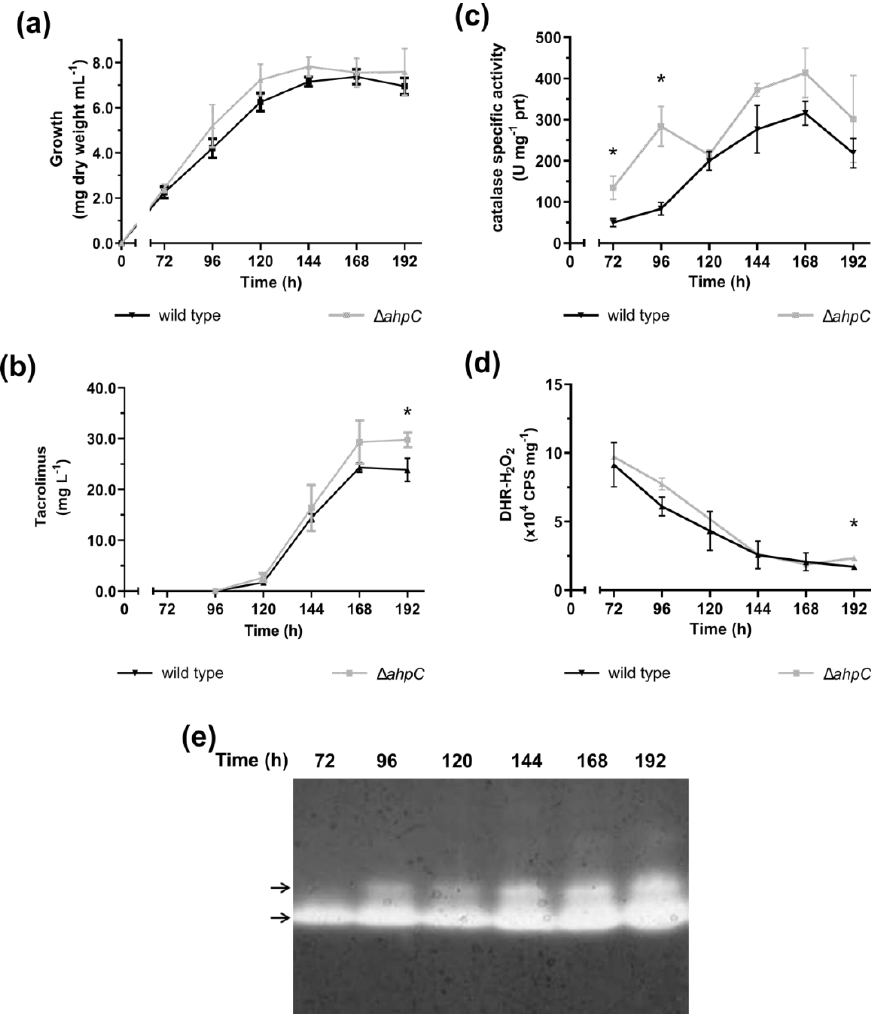
Figure 1. Characterization of S. tsukubaensis wild type (black lines) and ∆ ahpC (grey lines) cultures grown in MGm-2.5 medium: ( a ) growth curve; ( b ) tacrolimus production; ( c ) catalase specific activity and (d) intracellular H 2 O 2 levels. Vertical bars indicate standard deviation of the mean values; * indicates significant differences between wild type and ∆ ahpC , p < 0,05 (t-test with Holm-Sidak correction for multiple comparison). Results are the average of at least three independent experiments. ( e ) Native-PAGE of S. tsukubaensis cell extracts (30 µg total protein per lane) stained for catalase activity. Arrows indicate the two bands that display catalase activity.